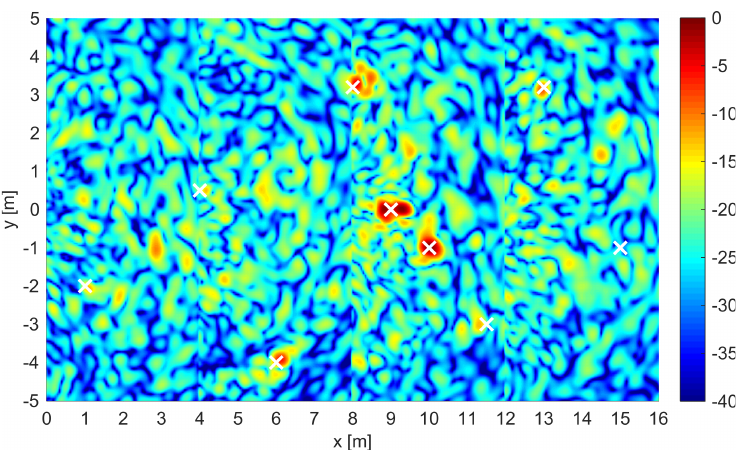
Figure 4. Image obtained by integrating two apertures for the scene containing nine targets and a rough surface ( h rms = 1.6 cm). The true position of targets is indicated with a white cross.